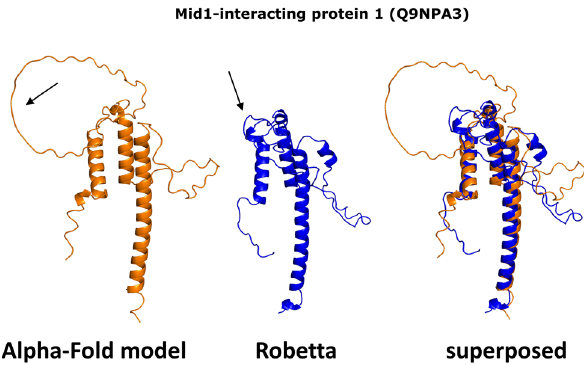
Figure 2: Comparison of AlphaFold and Robetta for Mid1 - interacting protein 1. The arrow shows the same domain in the AlphaFold and Robetta models.